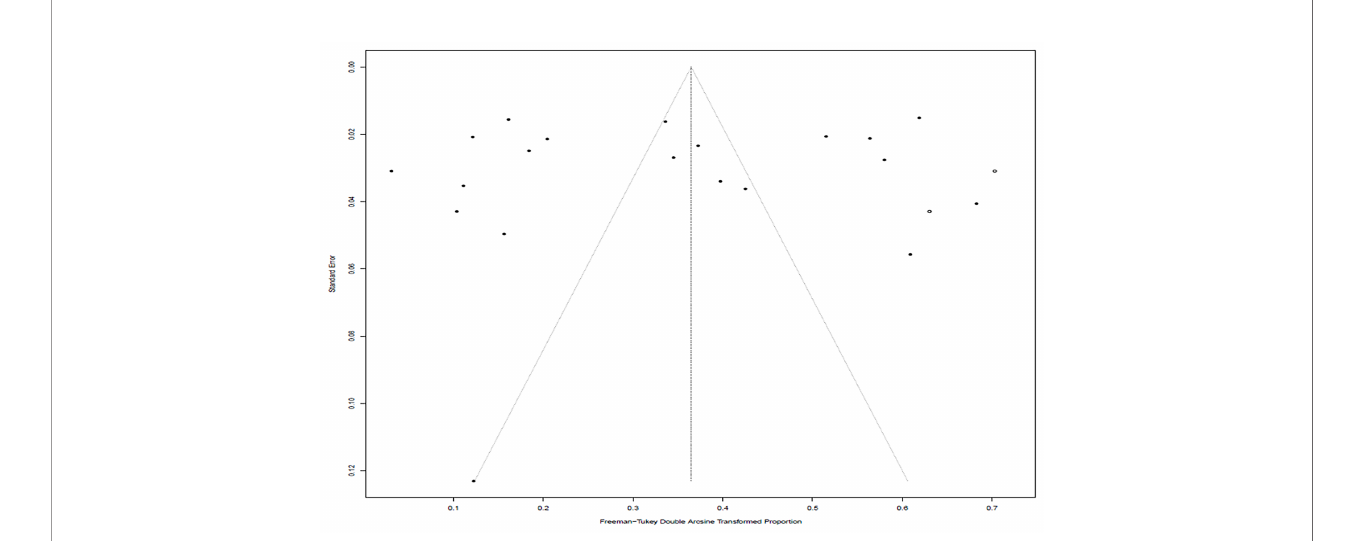
FIGURE 5 | The trim and fi lling test.